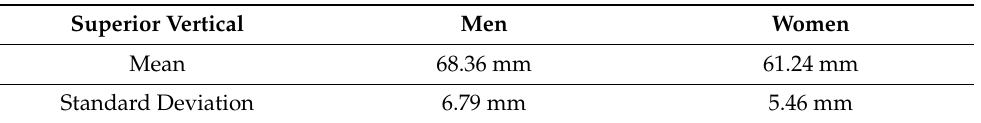
Table 2. Results obtained from the analysis of the sample employing the Vertical Ceph 3D method for the inferior vertical dimensions (I).